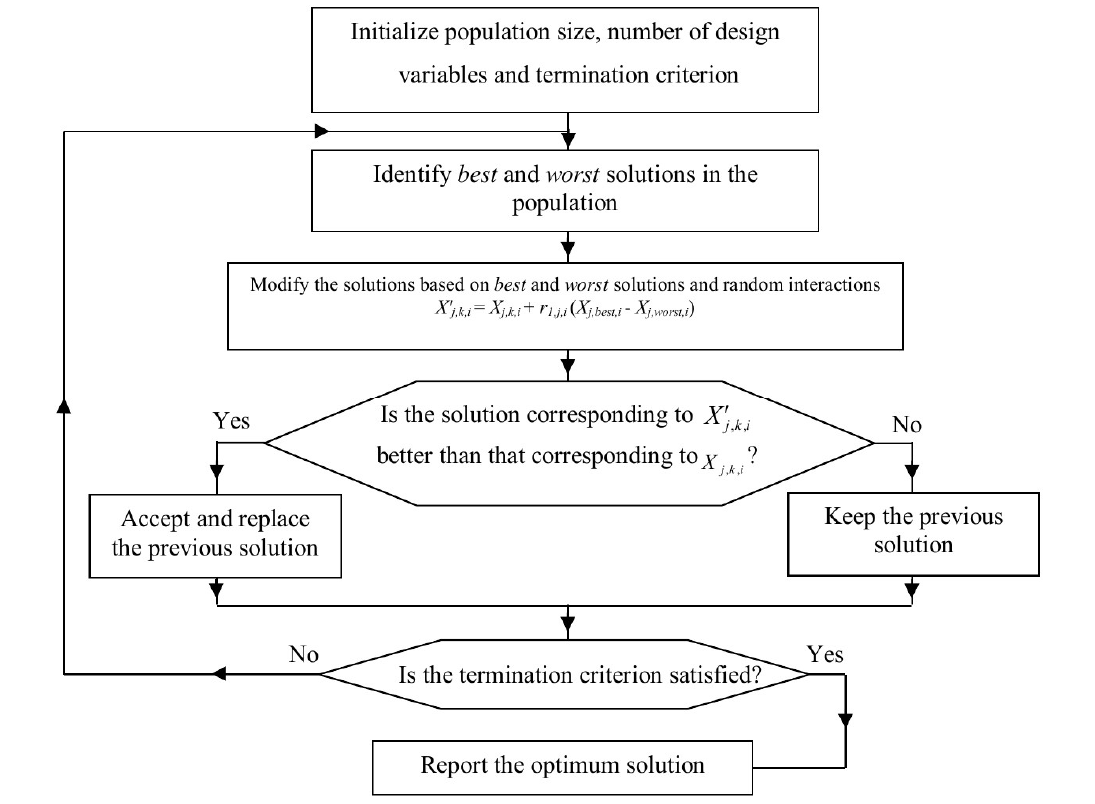
Fig. 1 . Flowchart of Rao-1